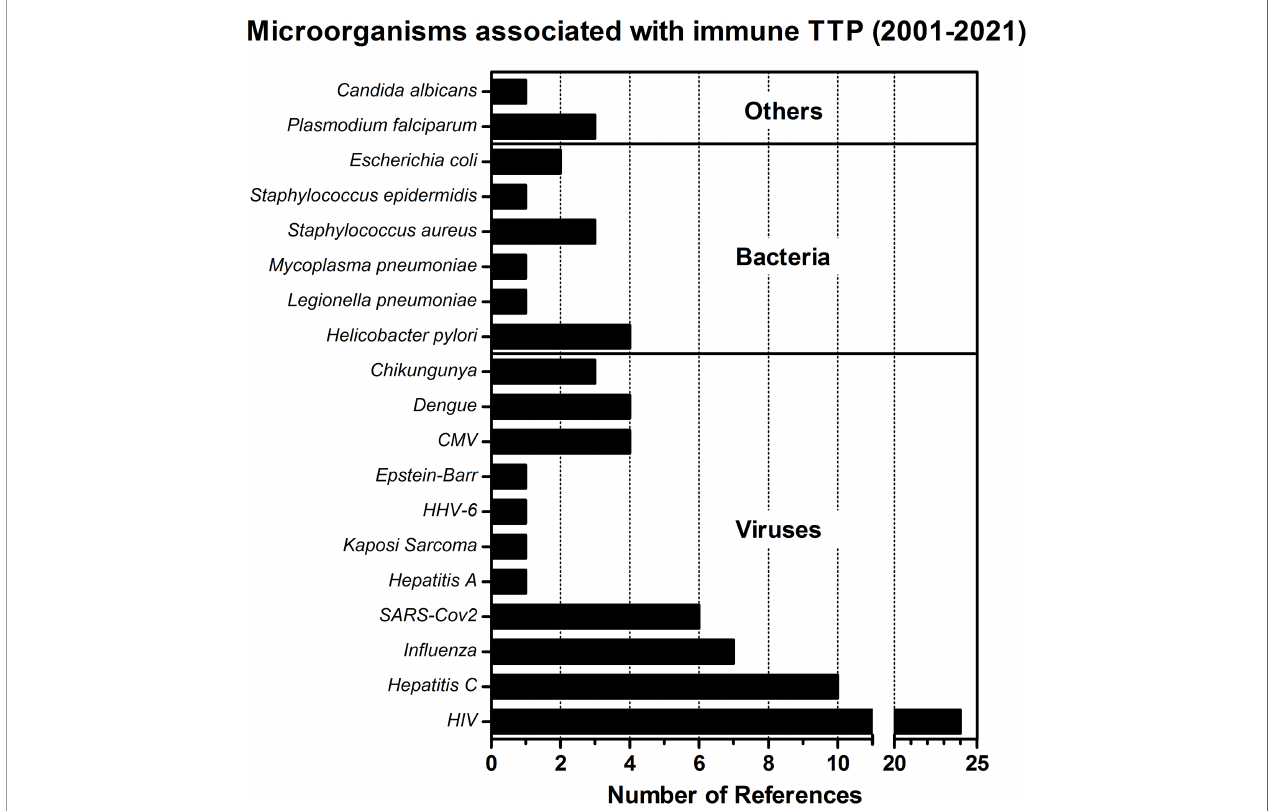
FIGURE 3 | Microorganisms associated with immune TTP. The number of obtained references for different pathogens associated with the development of iTTP are presented in this bar-chart. The literature search was performed using the PubMed database, employing the search terms ‘ thrombotic thrombocytopenic purpura ’ AND ‘ infection ’ NOT ‘ hereditary ’ NOT ‘ congenital ’ NOT ‘ immune thrombocytopenic purpura ’ AND ‘ Case Report ’ . References since 2001 (the year when ADAMTS13 was formally discovered and its structure annotated) were swept through to fi nd infectious microorganisms that could be identi fi ed as a trigger for immune TTP in case reports under speci fi c criteria: 1) the diagnosis of acquired TTP was done shortly after the infection was identi fi ed, or the infection was clearly associated as trigger of a relapse, 2) ADAMTS13 activity was preferably measured as <10%, 3) anti-ADAMTS13 autoantibodies were detected, con fi rming the diagnosis of immune TTP. The search was performed on the 28 th April